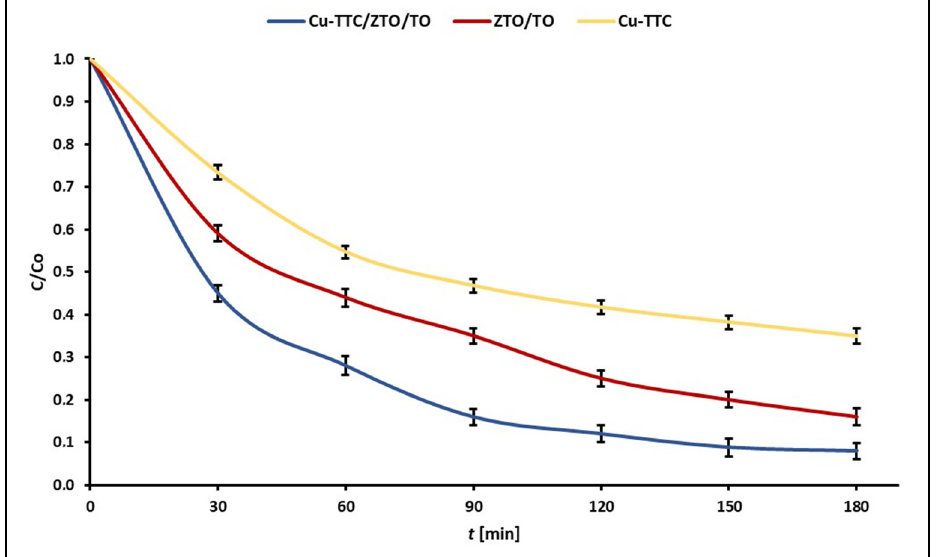
Figure 6. Evolution of experimental points of C/C 0 during the photocatalytic degradation of MB dye for the photocatalysts Cu-TTC/ZTO/TO, ZTO/TO and Cu-TTC.